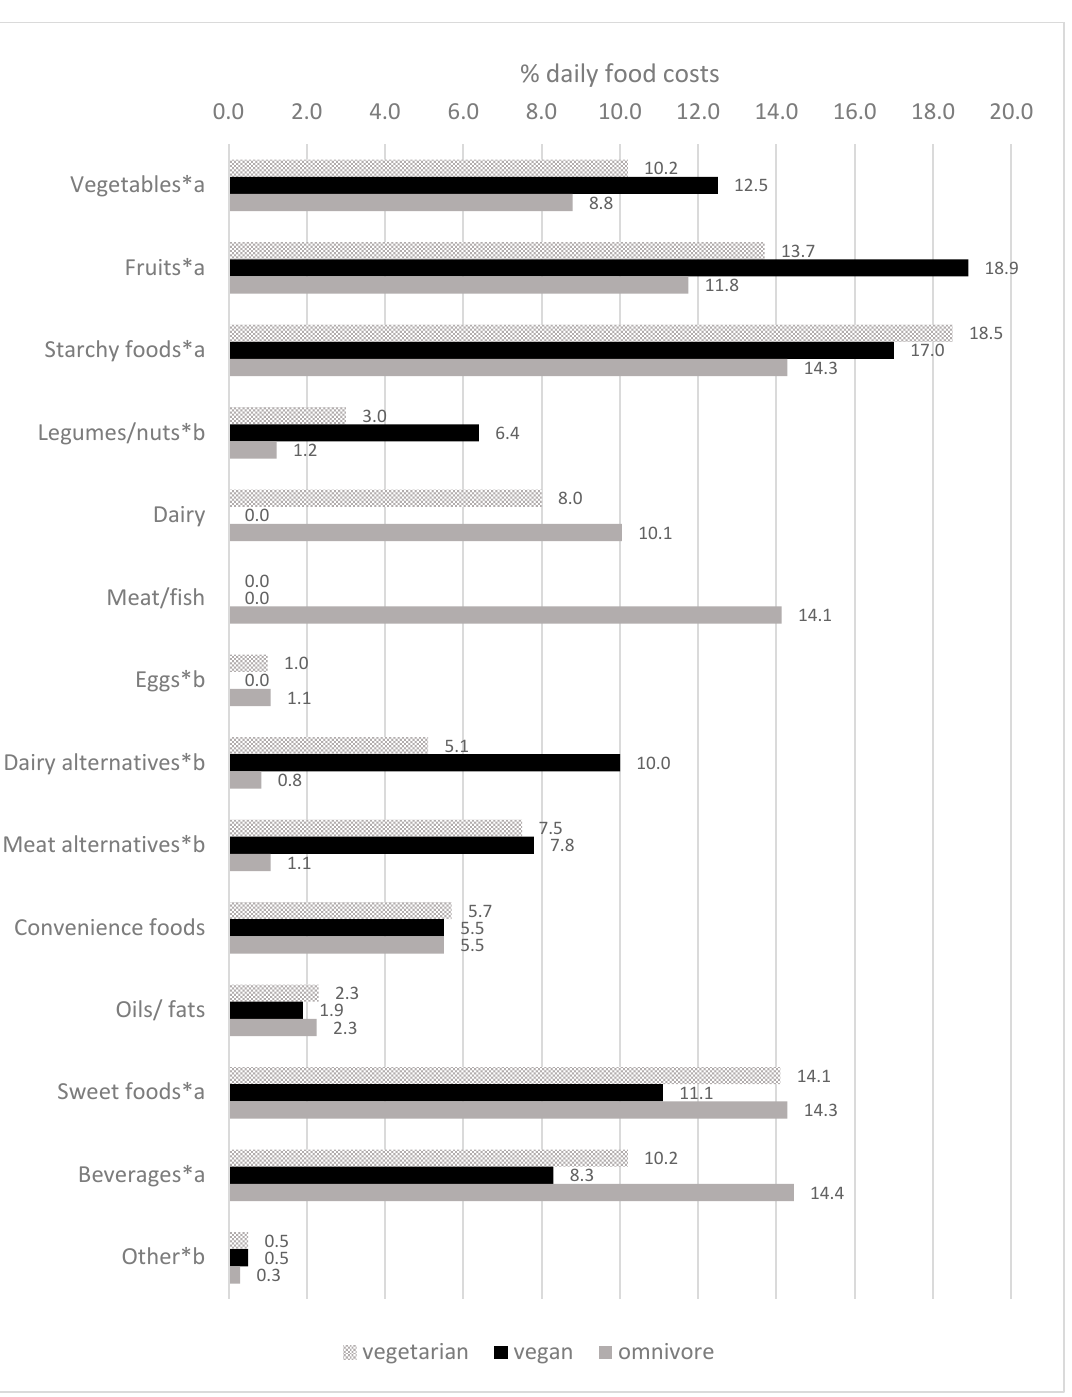
Figure 1. Daily food group costs as % of total daily food costs of participants of the VeChi Youth Study (n = 390) stratified by diet group (* indicates significant differences between diet groups; performed using a Ancova and b Kruskal–Wallis test).